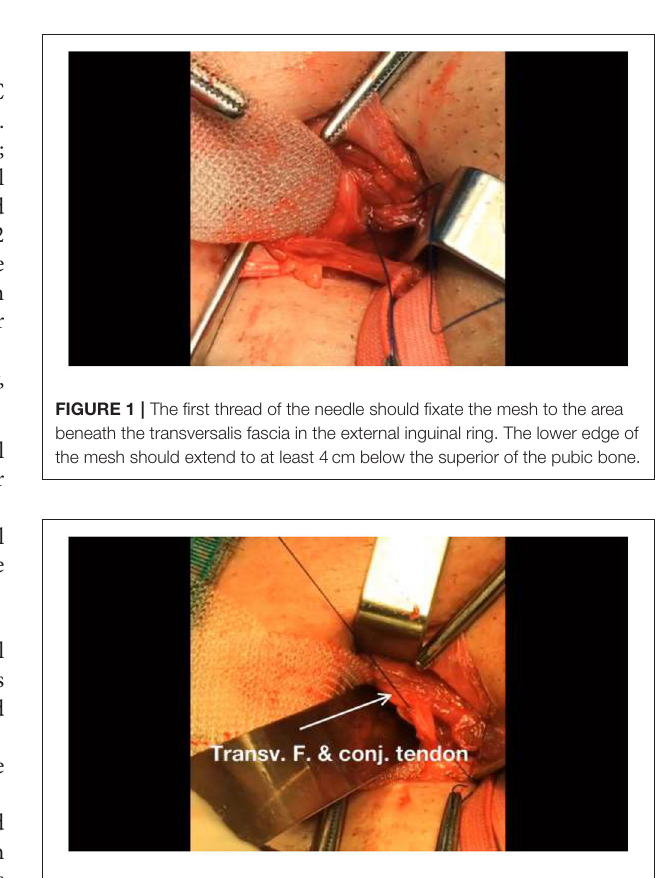
FIGURE 2 | Continue threading the same line of sutures to the internal transversalis fascia and conjoint